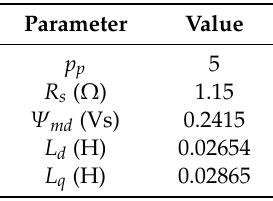
Table 1. Permanent magnet synchronous machine PMSM